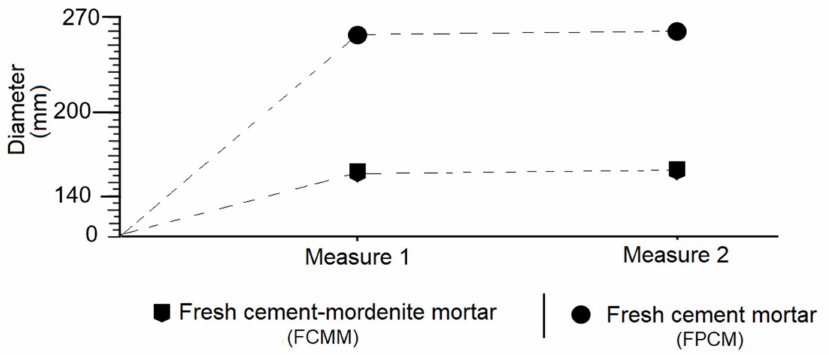
Figure 10. Consistency of fresh mortar of mordenite/cement (FCMM) and portland cement